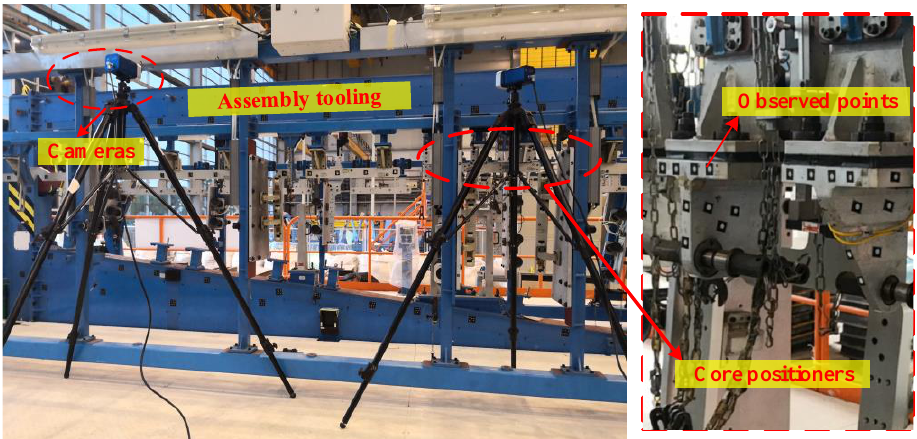
Figure 5. Layout of the facilities.